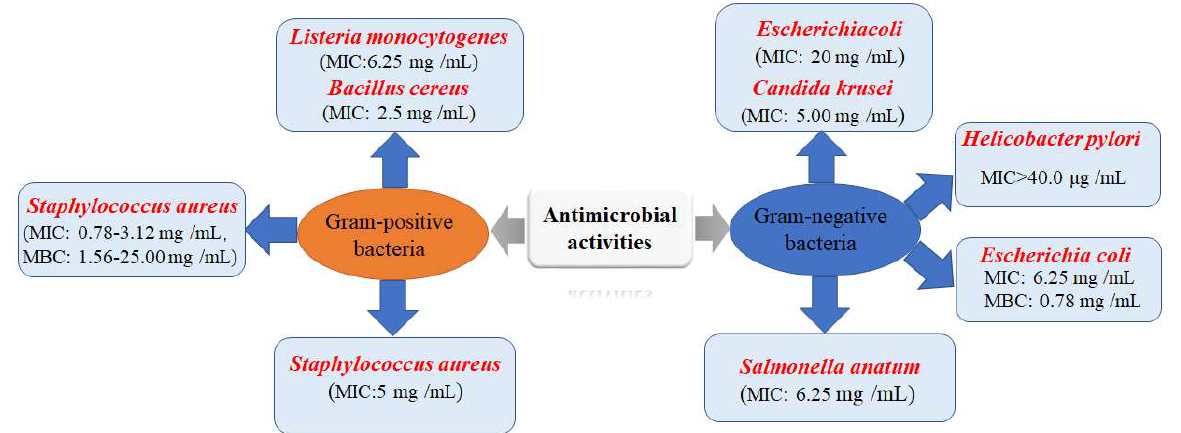
Figure 4. MICs and MBCs (mg/mL) of the extracts of P. capitatum against bacterial strains.